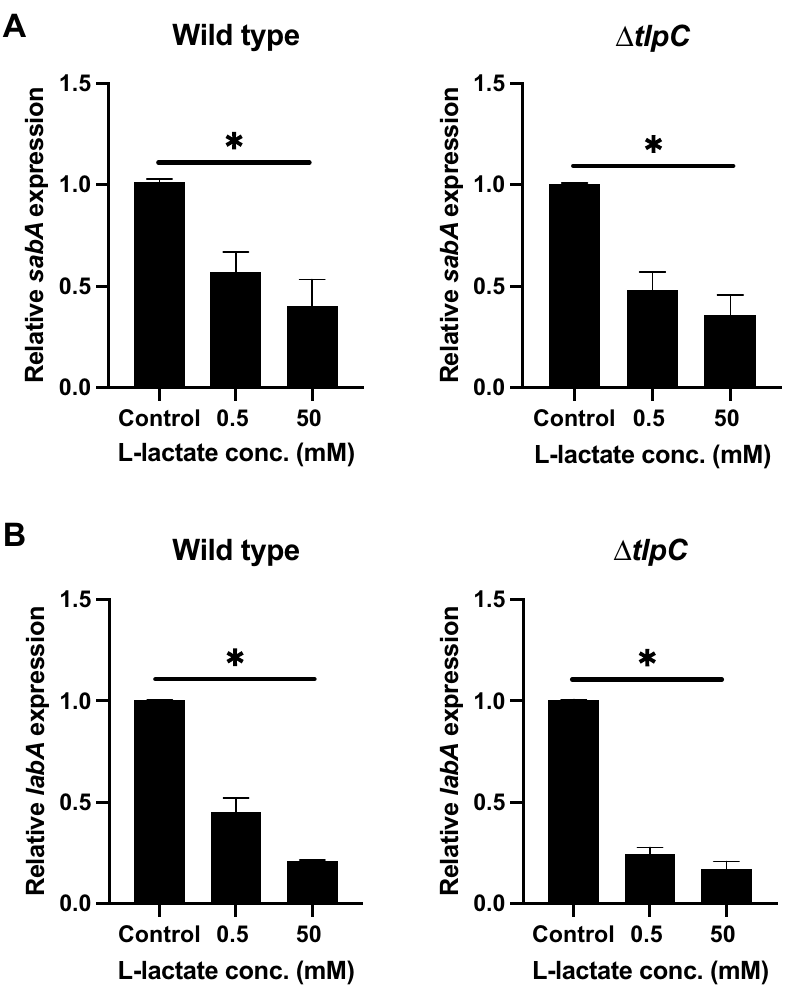
Figure 3. The lactate chemosensor TlpC is not involved in sabA and labA downregulation. Relative expression levels of the H. pylori adhesin genes sabA ( A ) and labA ( B ) in wild-type and ∆ tlpC mutant H. pylori after incubation of the bacteria in RPMI 1640 medium without glucose (control) or supplemented with 0.5 mM or 50 mM of l-lactate for 2 h. Target gene expression was normalized against that of the housekeeping gene gyrB . Gene expression levels in the control were set to 1. Data represent the means and standard deviation of duplicate samples and the average of three independent experiments. *P < 0.05; ns, nonsignificant, using ANOVA followed by a Bonferroni